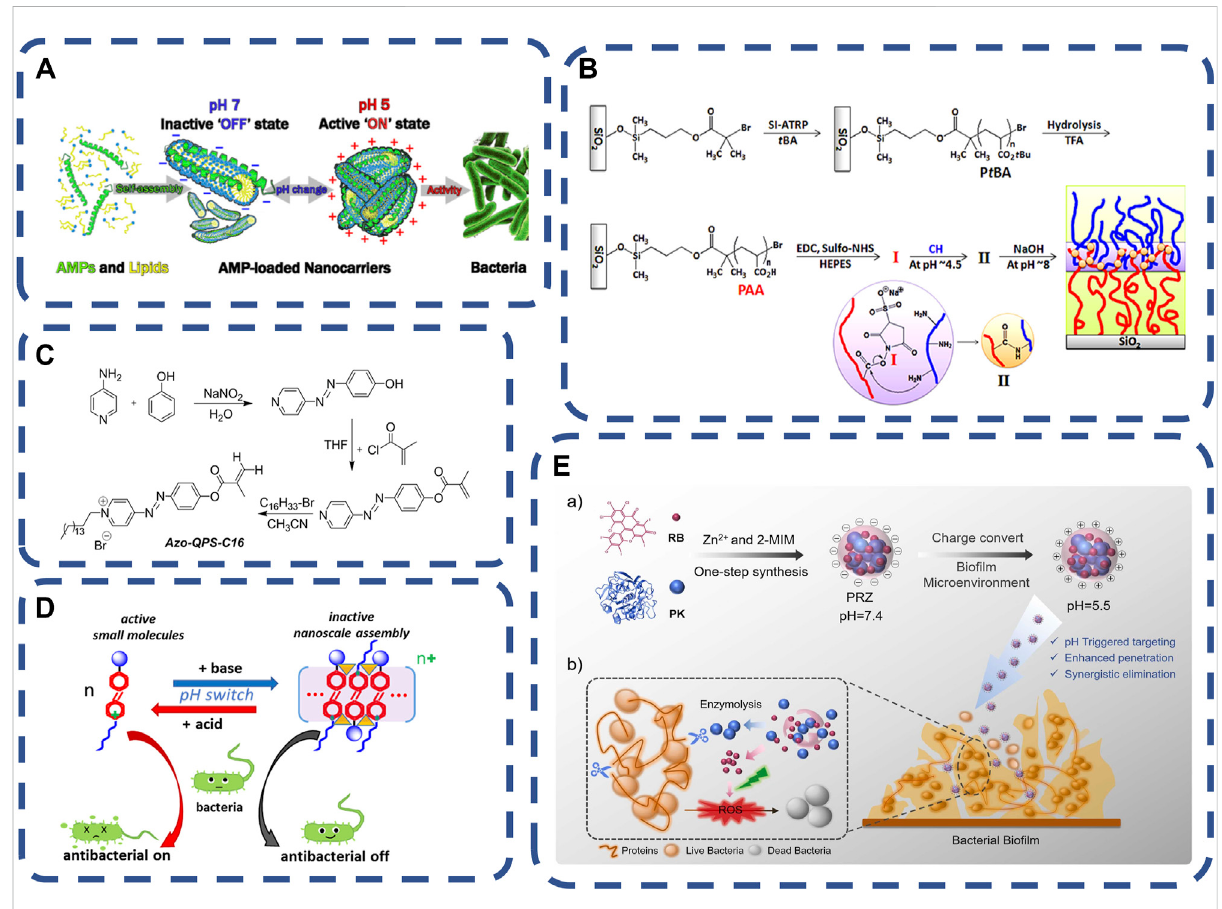
FIGURE 3 (A) Amphiphilic antimicrobial peptides are transformed from core-shell cylindrical micelles with a cross-sectional diameter of 5.5 nm and a length of 23 nm at pH 7.0 to branched chain linear micelle aggregates at pH 5.0. At pH 5.0, positively charged LL-37/OA aggregates have